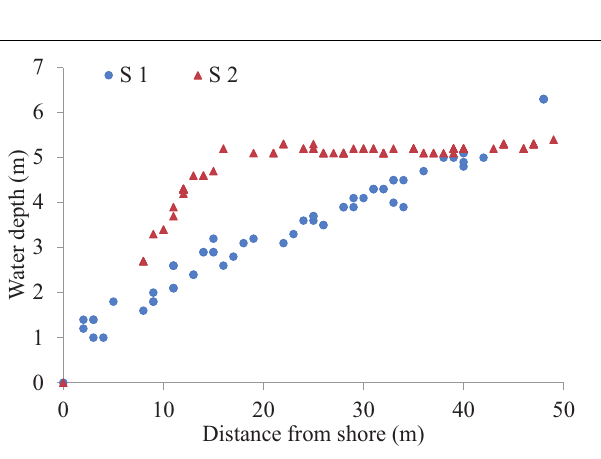
TABLE 1 | Substratum at 10 m increments along 50 m transects at survey sites S1 and S2. Distance from shore (m) S1 S2